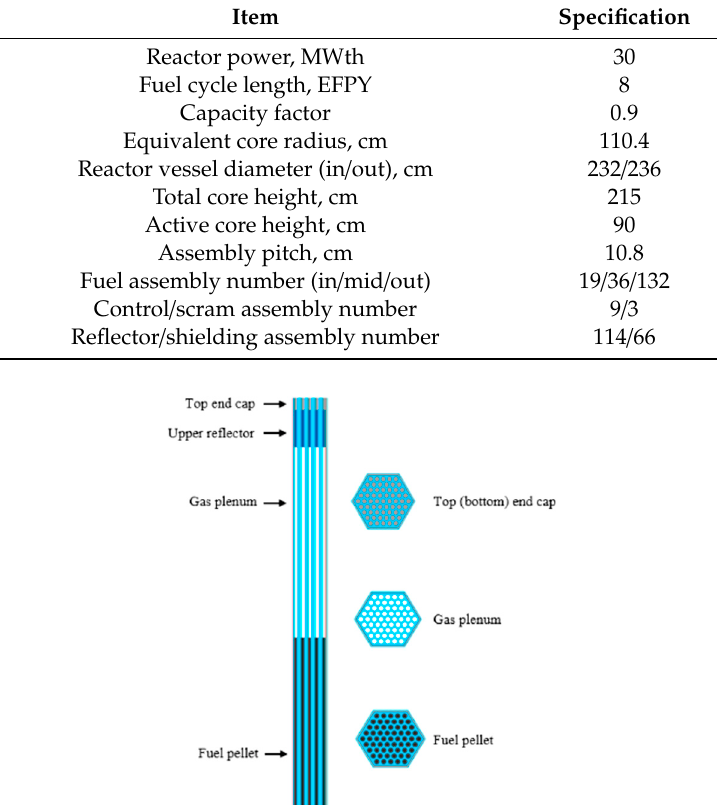
Table 1. Design parameters of the core.